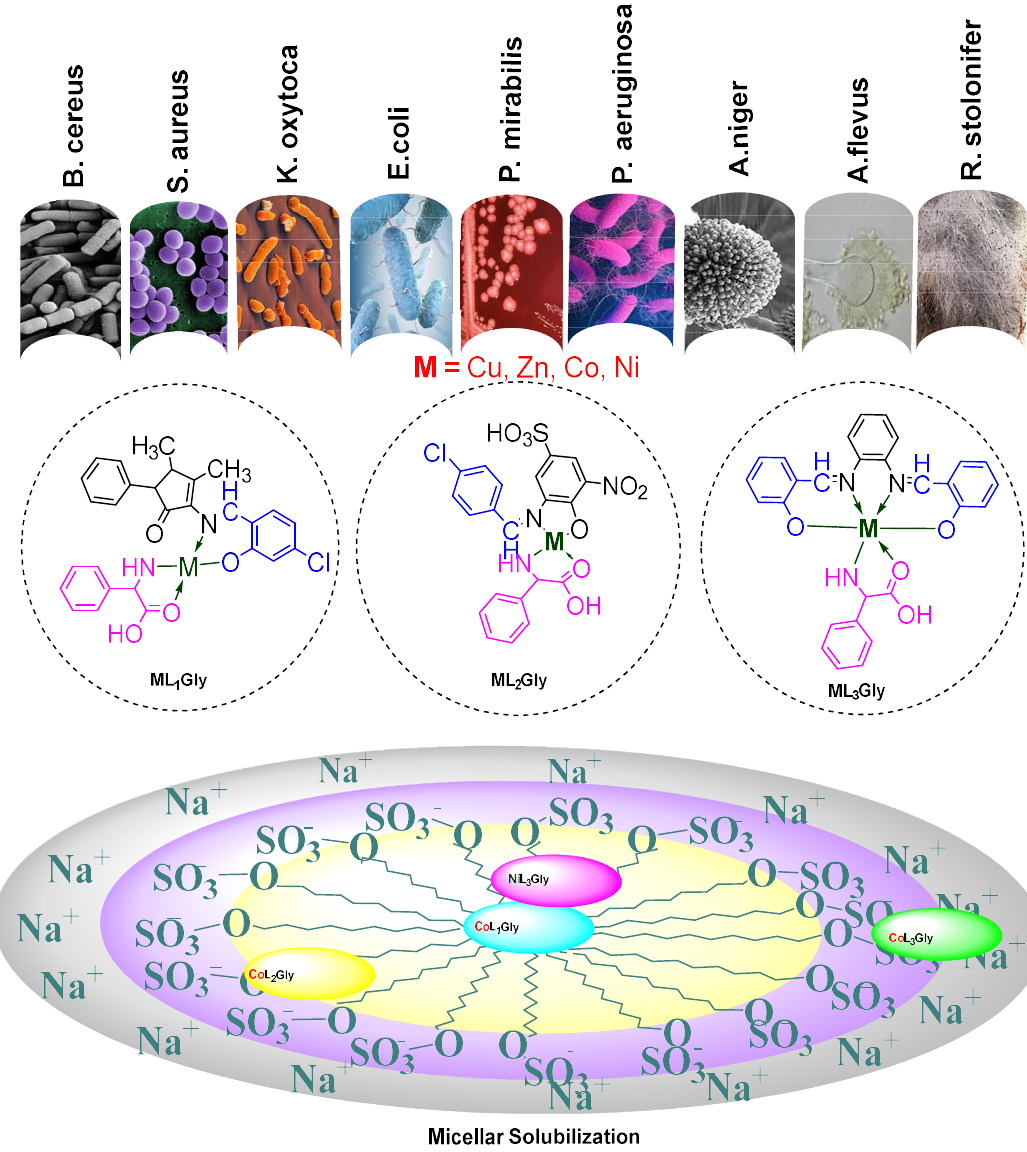
Figure 4. Proposed locus of metal complexes in the micelles of SLS.